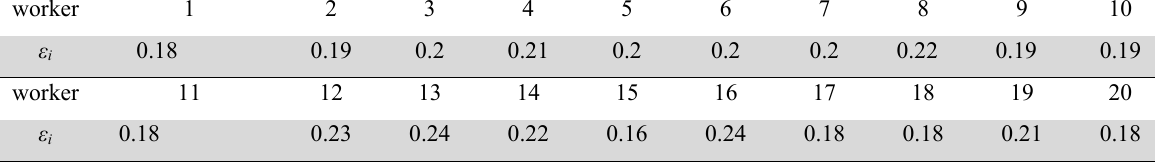
Coefficient of influencing level for worker i completing multiple tasks within a seru ( φ i )